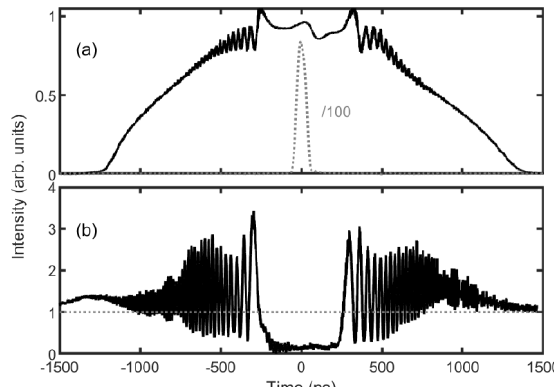
Fig. 1. Experimental temporal intensity profiles of the pulse wave (a) and of the continuous seed wave (b) at the input (dashed grey line) and output (solid black line) of the